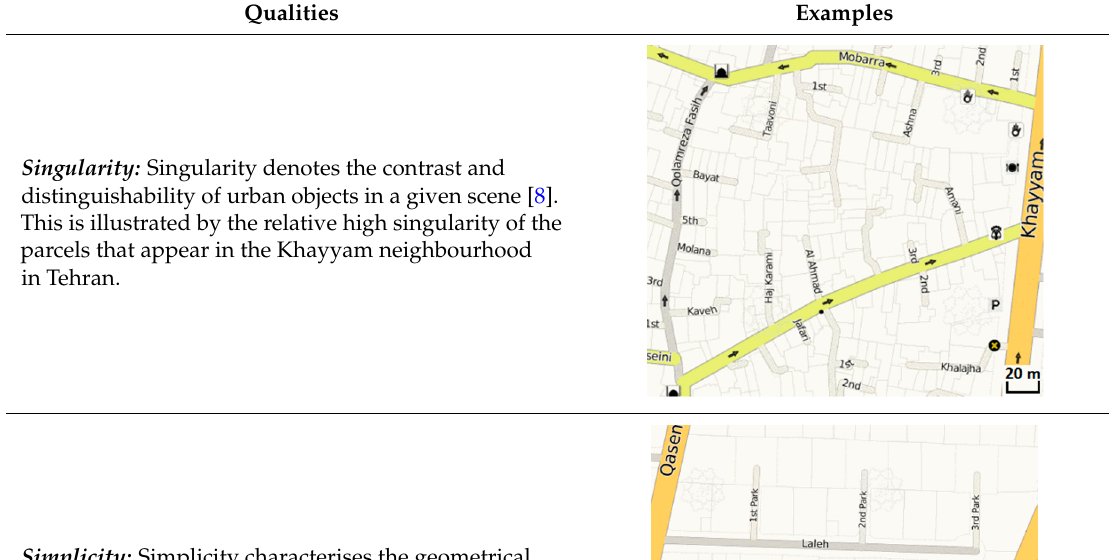
Table 1. Lynch’s legibility qualities. Table 1 . Lynch’s legibility qualities. Table 1 . Lynch’s legibility qualities. Table 1 . Lynch’s legibility qualities. Table 1 . Lynch’s legibility